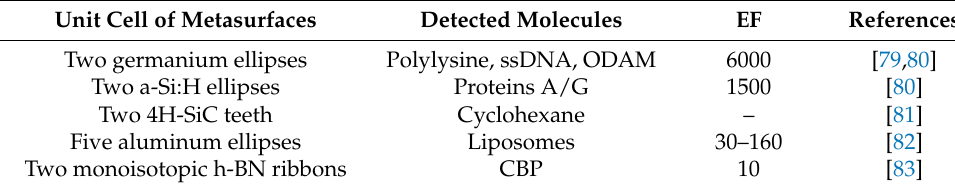
Table 2. Unit cell of metasurfaces, detected molecules and the enhancement factor (EF) for surface-enhanced infrared absorption sensors (ssDNA = single-stranded DNA; ODAM = human odontogenic ameloblast-associated protein; a-Si:H = anisotropic hydrogenated amorphous silicon; 4H-SiC = 4H-silicium carbide; h-BN = hexagonal boron nitride; CBP = 4,4 (cid:48) -bis(N-carbazolyl)-1,1 (cid:48) -